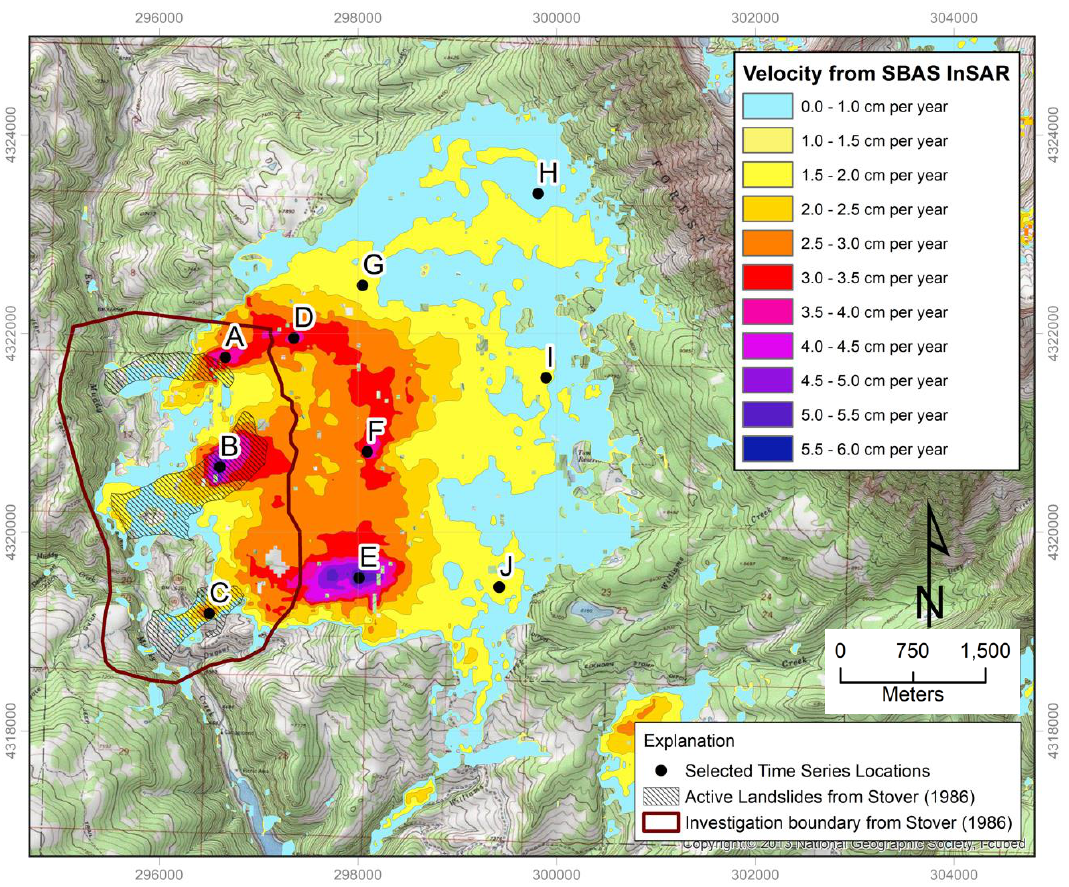
Figure 8. Map classified by LOS velocity by SBAS InSAR greater than 0 cm/year (modified from [51]).